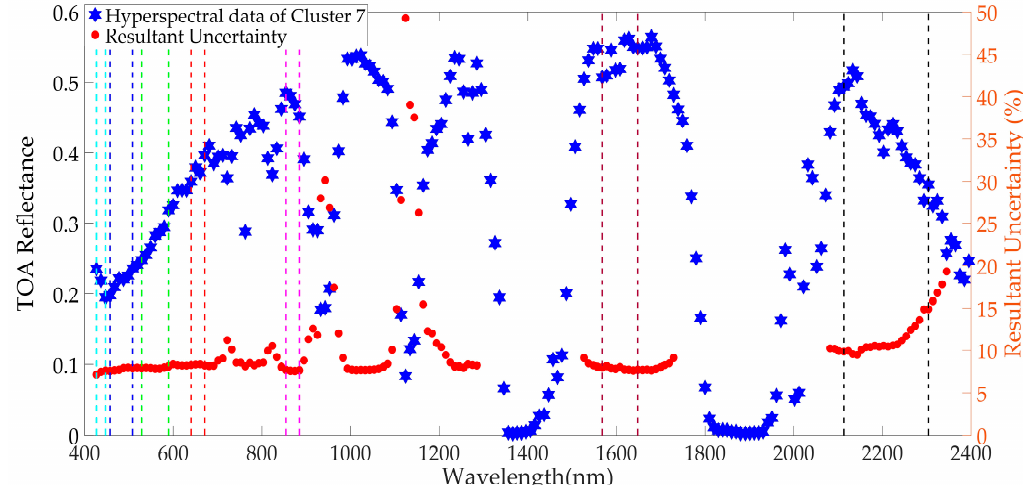
Figure A4. Estimated representative hyperspectral profile of Cluster 6 and its resultant uncertainty.